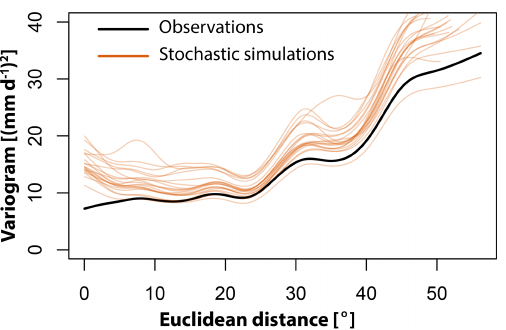
Figure A2. Comparison of observed (black) and simulated (orange) variograms for 20 simulation runs where the phases were randomized for each station